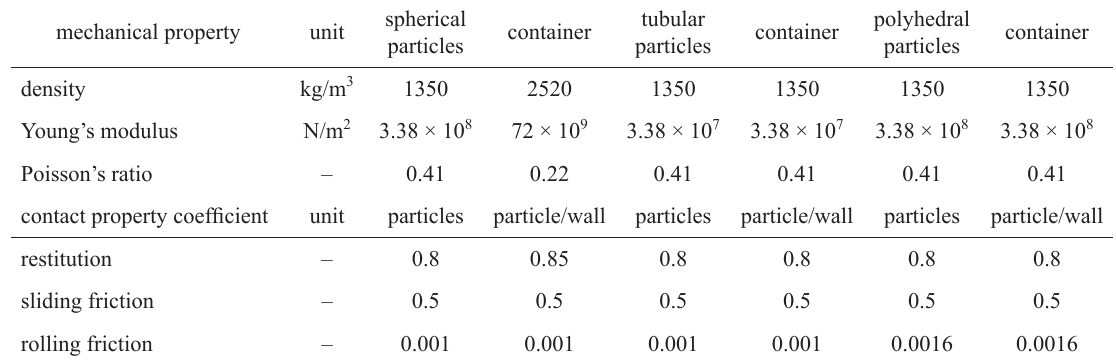
Table 1 Mechanical and contact properties used in the DEM